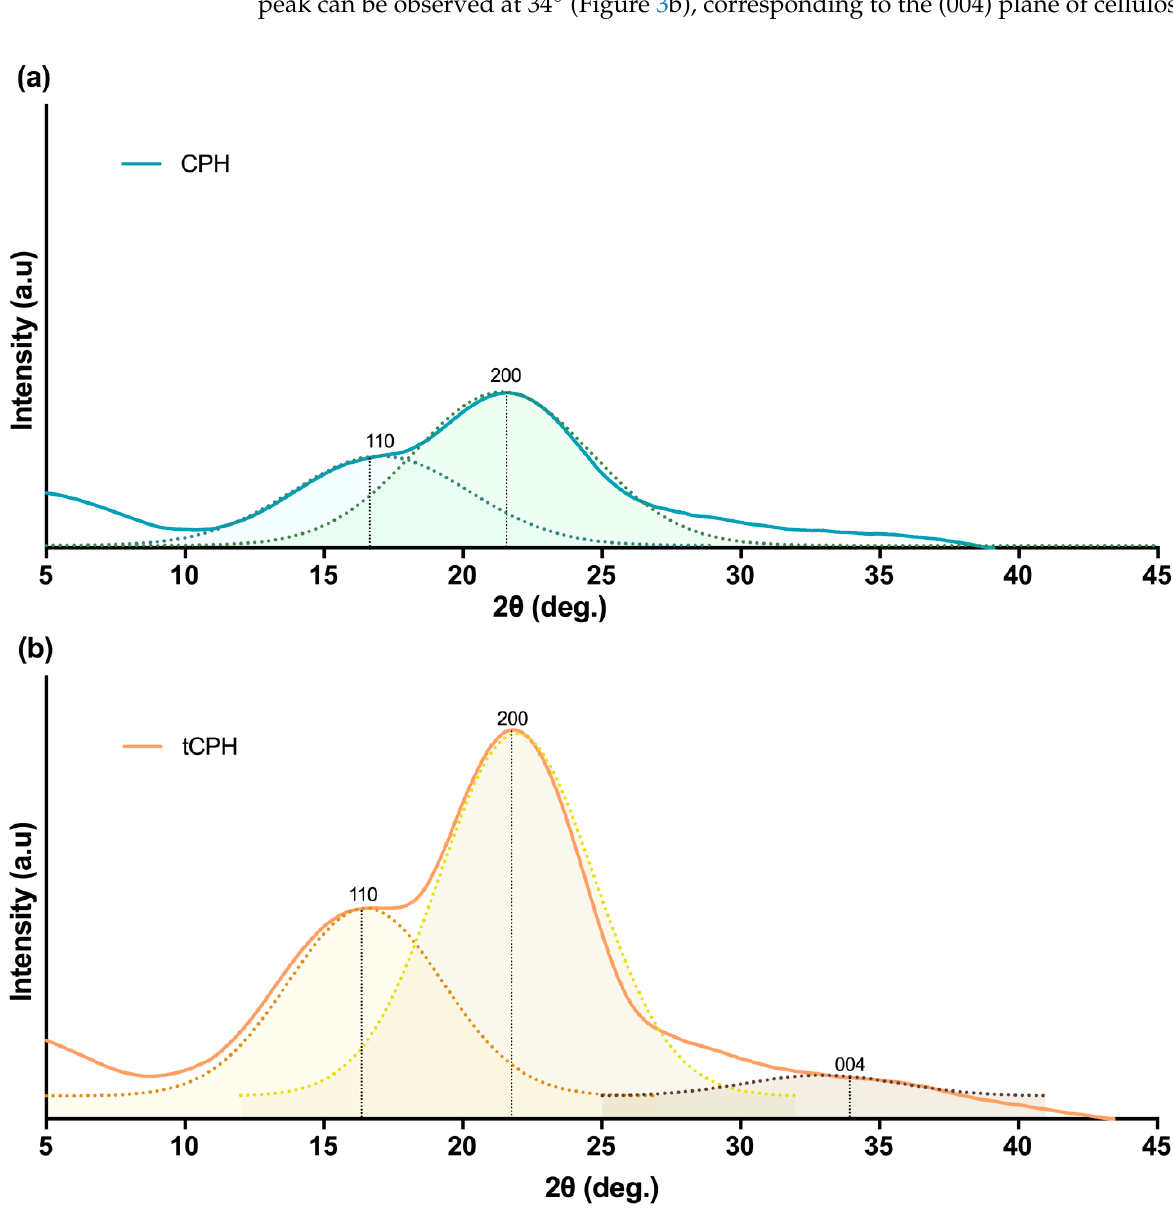
Figure 3. ( a ) XRD pattern for CPH with the deconvolution of main phases. ( b ) XRD pattern for tCPH with the deconvolution of main phases.